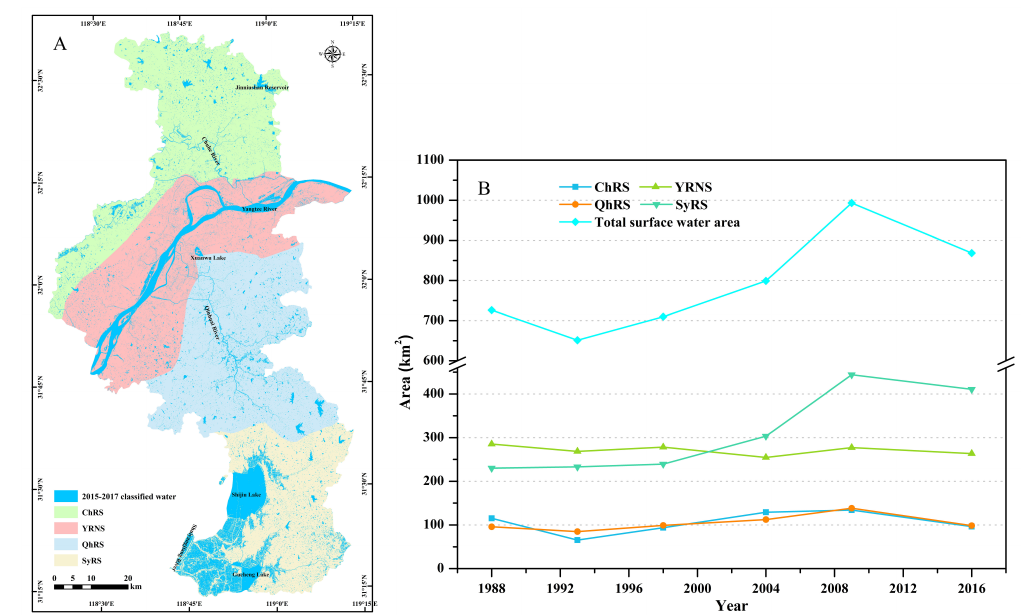
Figure 7. Dynamic changes of surface water extents in four sub-basins: ( A ) division of the water system within the study area and ( B ) areal changes in surface water extent in all four sub-basins during the period